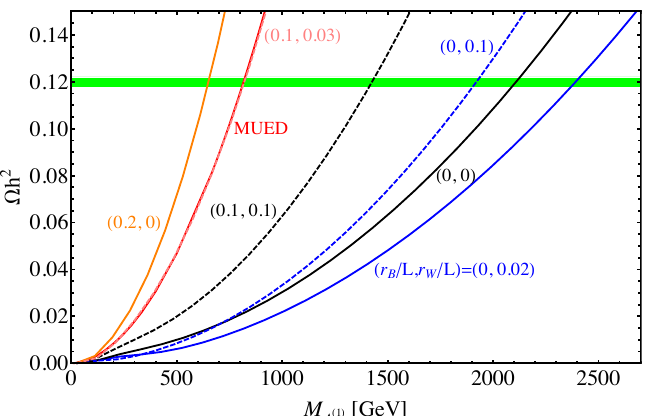
Figure 6 . Relic density (cid:10) h 2 as a function of DM mass M Di(cid:11)erent colors and line-styles indicate di(cid:11)erent ( r B , r W ) values. The green band indicate (cid:10) h 2 from the result of Planck 2015